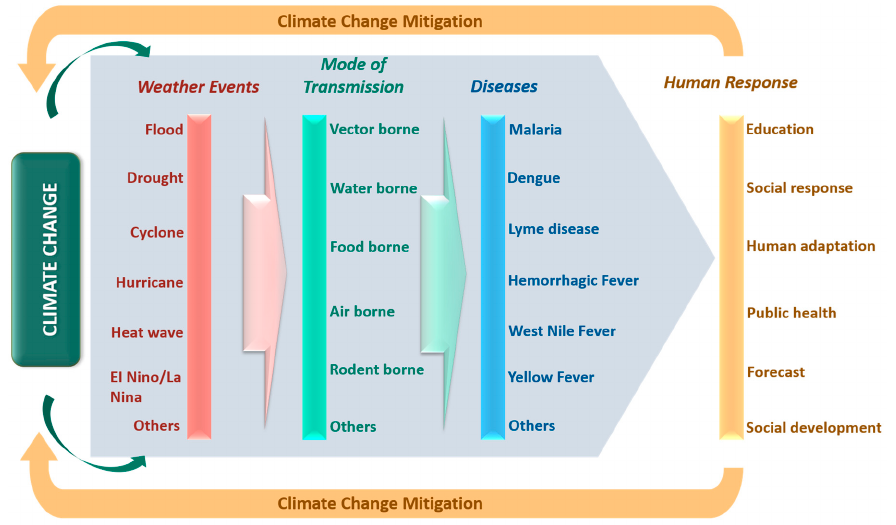
Figure 1. The relationships between climate change, extreme weather events and associated diseases with their mode of transmission. It also further represents possible urgent human responses for mitigation of climate change adapted from